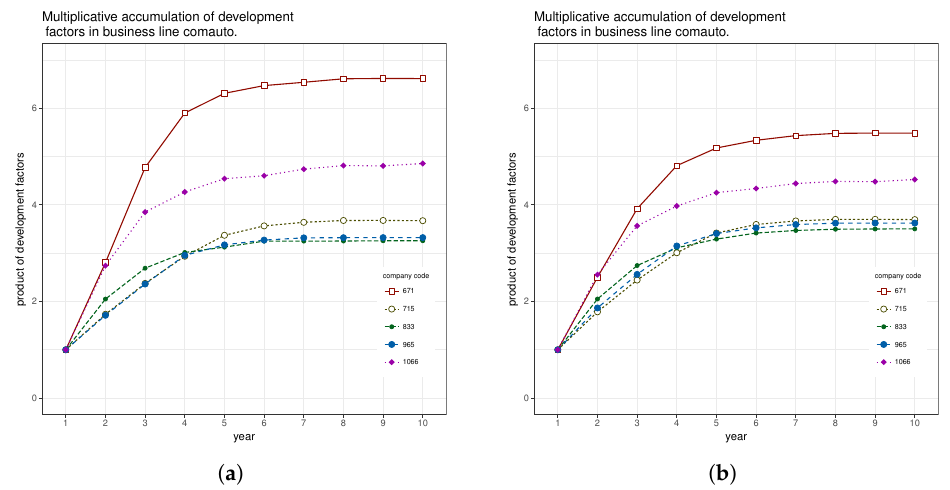
Figure 1. Multiplicative accumulation of development factors ( a ) without and ( b ) with credibility